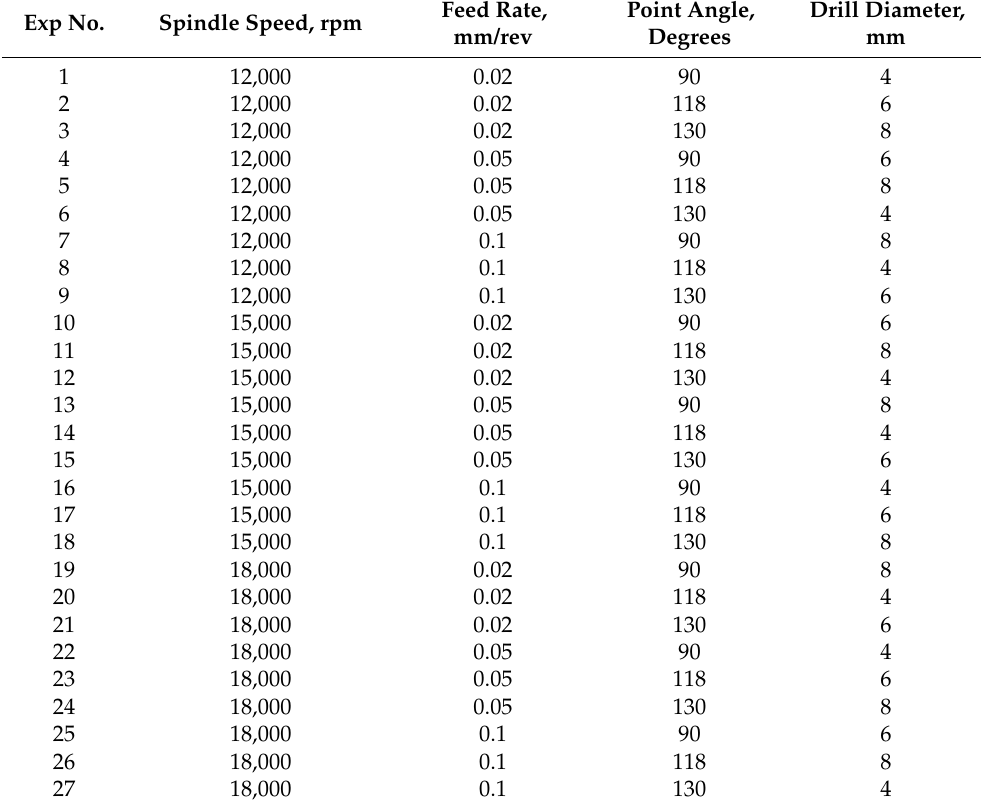
Table 2. Taguchi’s l–27 orthogonal